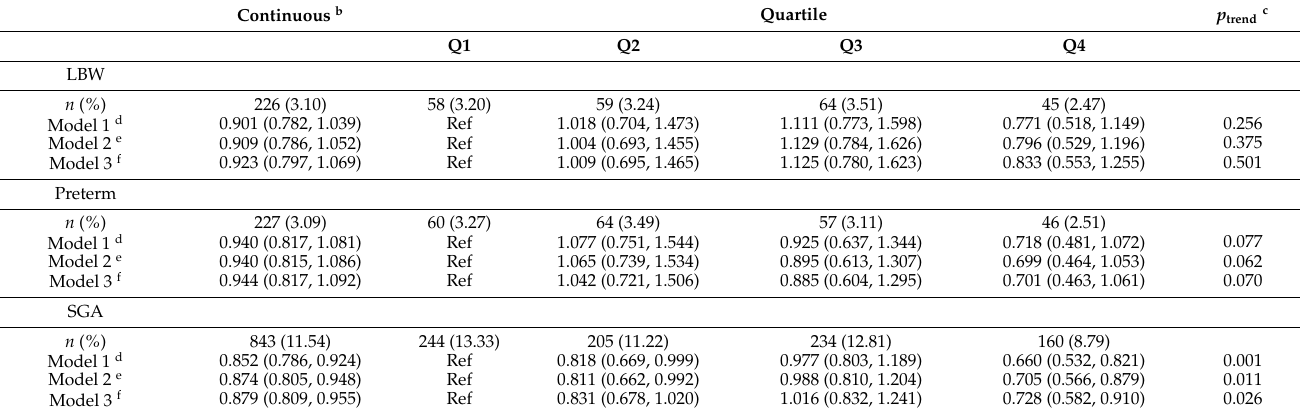
Table 4. Associations between the high B-vitamin dietary pattern score and dichotomous birth outcomes a